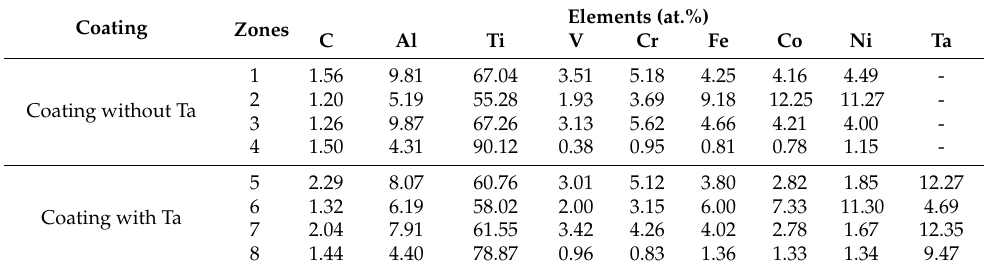
Figure 3 indicates the microstructure of the two coatings under different magnifications. For the coating without Ta, a large number of irregular grains were uniformly distributed in the coating, among which wide and irregular honeycomb-like grain boundaries were connected with each other (Figure 3a). When Ta was introduced into the coating, the irregular grains were transformed into regular equiaxed grains with comparatively smooth edges, accompanied with honeycomb-like grain boundary that was greatly reduced in volume fraction (Figure 3b). A clear observation revealed that some fine dendrites were wrapped in the grains of the two coatings, and their volume fraction increased upon introducing Ta. Figure 3c–f show the images with high magnification. Besides the grains (marked as 1 and 5) and dendrites (marked as 4 and 8), the other two morphological phases could be obviously observed in the grain boundary, corresponding to the raised zones (marked as 3 and 7) and shrunken zones (marked as 2 and 5). EDS was applied to identify the chemical compositions of the abovementioned phases, and the results are shown in Table 2. Zone 1 is rich in Ti (67.04 at.%). Small quantities of Al (9.81 at.%), V (3.51 at.%), Cr (5.18 at.%), Fe (4.25 at.%), Co (4.16 at.%), and Ni (4.49 at.%) were also detected. Besides those elements, Ta was found in Zone 5. Combined with the XRD results, the grains in the two coatings could be confirmed as a α (Ti) solid solution, in which α -Ti with close-packed hexagonal structure played the role of solvent, and other alloying elements acted as solute. Zone 4 is rich in Ti and C, indicating the dendrites could be determined as TiC secondary solid solution. When Ta was introduced in the coating, Ta was involved in TiC, which displaced Ti atoms in the lattice due to their similar atomic radius. The raised zones could be confirmed as α (Ti) due to their similar chemical compositions with the grains. The shrunken zone (Zone 2) in the coating without Ta mainly contained Ti (55.28 at.%) and Ni (11.27 at.%), followed by Al (5.19 at.%), Cr (3.69 at.%), Fe (9.18 at.%), and Co (12.25 at.%). The zone could be identified as Ti 2 Ni, a secondary solid solution. As mentioned above, the atomic radius values of Ti, Al, and Cr are similar, and the electronegativity values among the three elements are about the same (Ti: 1.54, Al: 1.61, and Cr: 1.66), suggesting that the Al and Cr atoms could replace the Ti atoms in the Ti 2 Ni lattice. In the same manner, the Ni atoms in Ti 2 Ni could be substituted for Co and Fe atoms due to the close values in atomic radius and electronegativity (Ni: 1.24 Å in atomic radius, 1.91 in electronegativity; Co: 1.26 Å in atomic radius, 1.88 in electronegativity; and Fe: 1.27 Å in atomic radius, 1.83 in electronegativity). In addition, the atomic ratio of Ti + Al + Cr to Ni + Co + Fe was calculated as 1.96: 1, relatively close to 2:1. Similarly, the shrunken zone (Zone 6) in the coating with Ta was Ti 2 Ni. Based on the above analyses, the microstructure consisted of primary α (Ti), eutecticum ( α (Ti) + Ti 2 Ni), and reinforcement TiC. The increase in the number of TiC and eutecticum is closely associated with Ta. Table 2. Chemical compositions of marked zones shown in Figure 3. Coating Zones